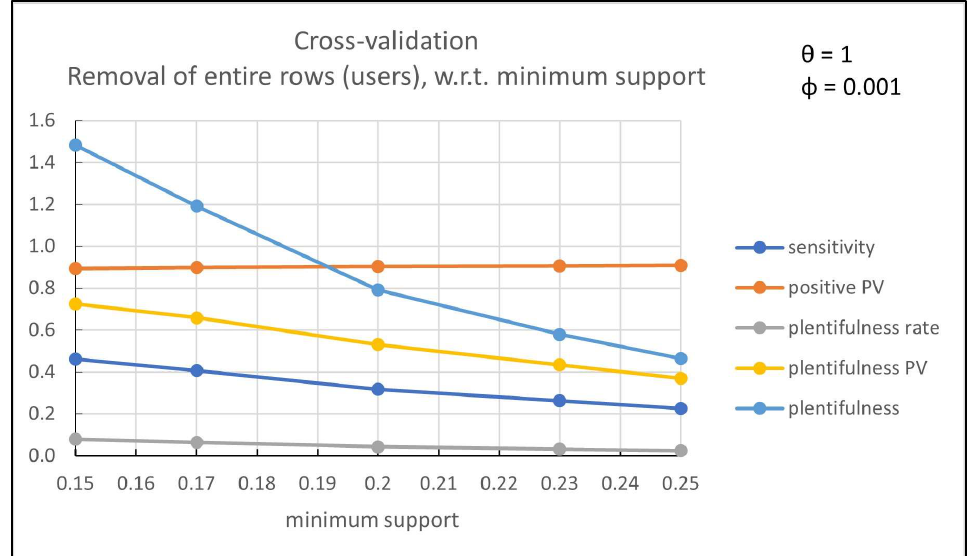
Figure 3. Cross-validation results (100% removal, with respect to minimum support).